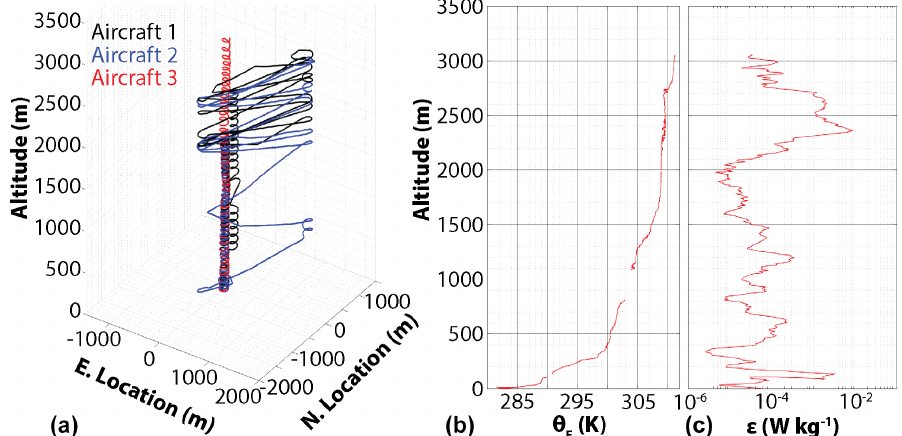
Figure 6. Representative DH2 flight trajectories from IDEAL (a) , with high-vertical resolution post-flight retrieval of virtual potential tem- perature (center) and turbulent kinetic energy dissipation rate (b) .